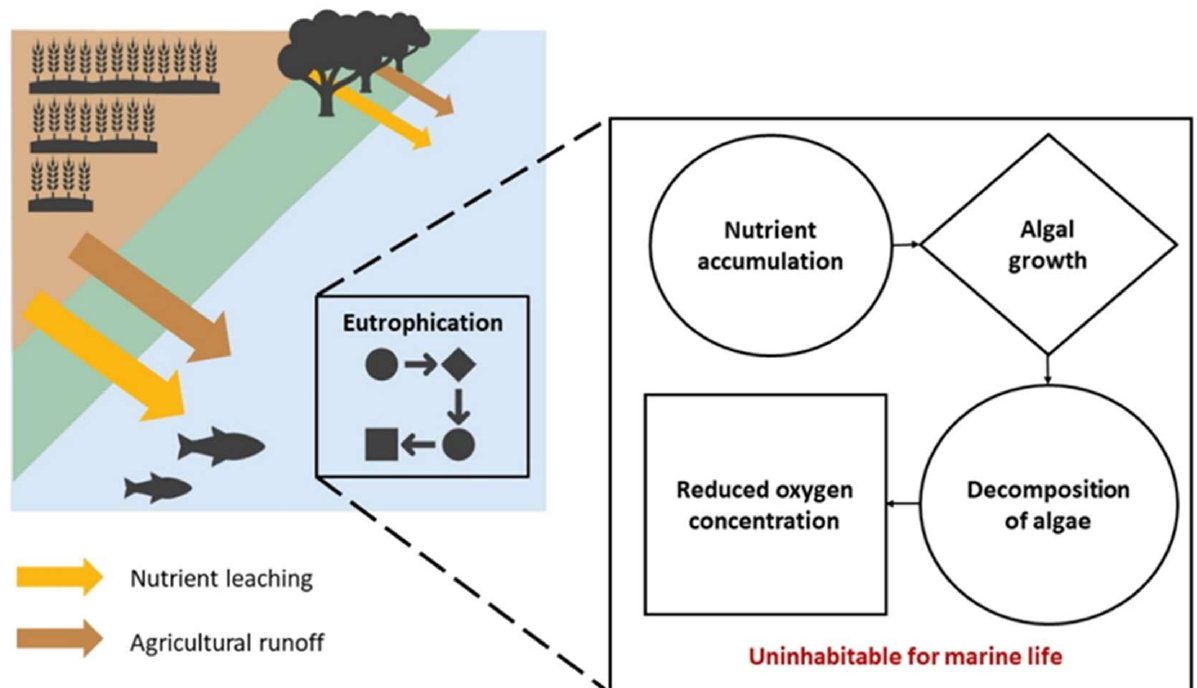
Figure 8. Schematic representation of the eutrophication process caused by agricultural runoff and nutrient leaching, creating a habitat that is uninhabitable for marine life. Perennial crops help reduce both nutrient leaching and agricultural runoff (based on information from [18,62,114]).